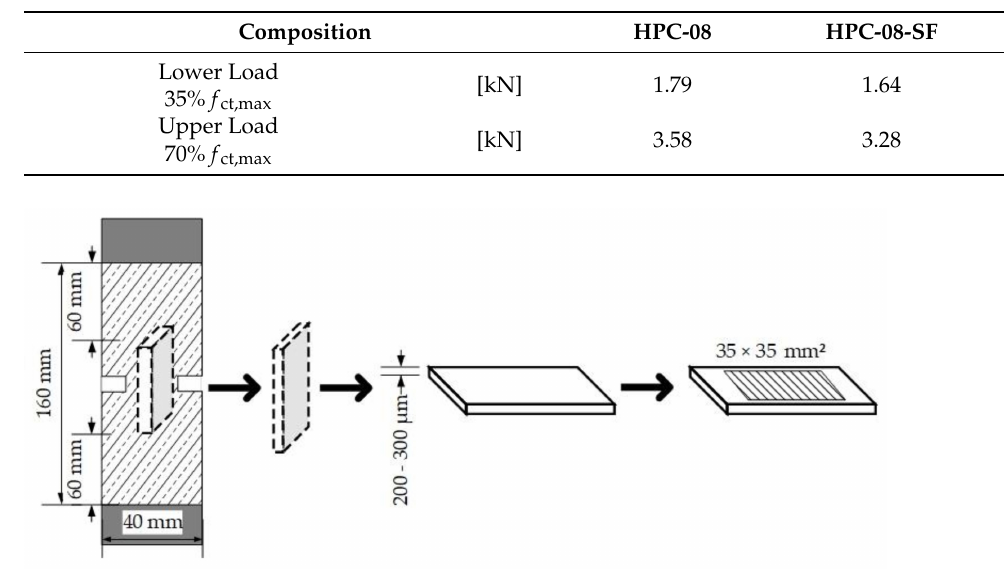
Figure 3. Preparation of thick sections from the middle region (notch region) of the test